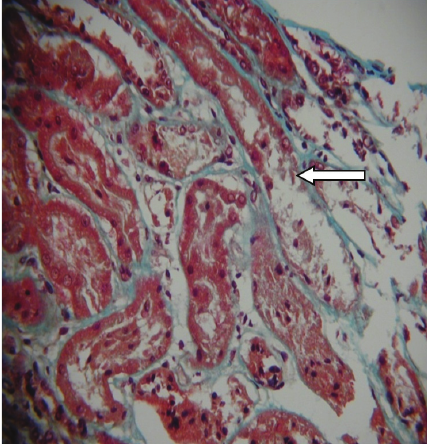
F 1: Kidney allogra biopsy: light microscopy showing acute tubular necrosis (arrow marked with magni�cation